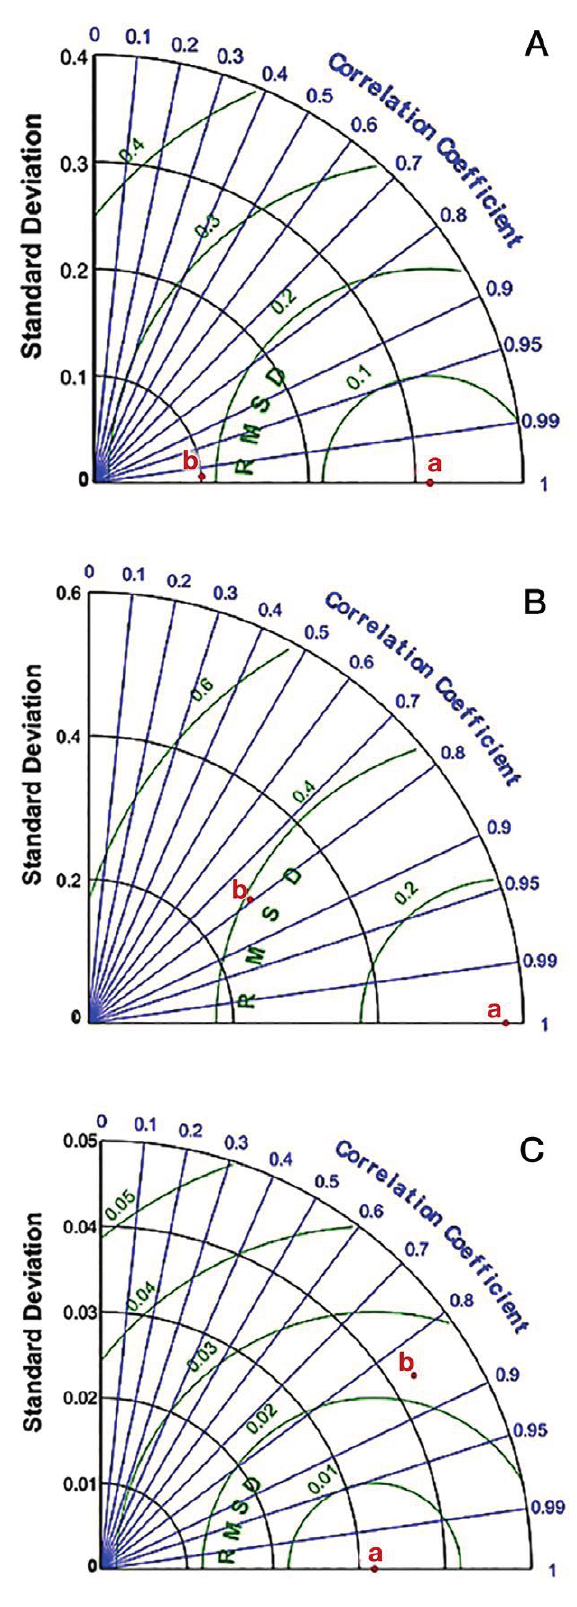
Fig. 9. – Taylor (2001) diagram of model performance for three cases: A, Tw; B, Tz; and C, Hs. In all cases a, Pratolongo et al. (2010) results and b, model